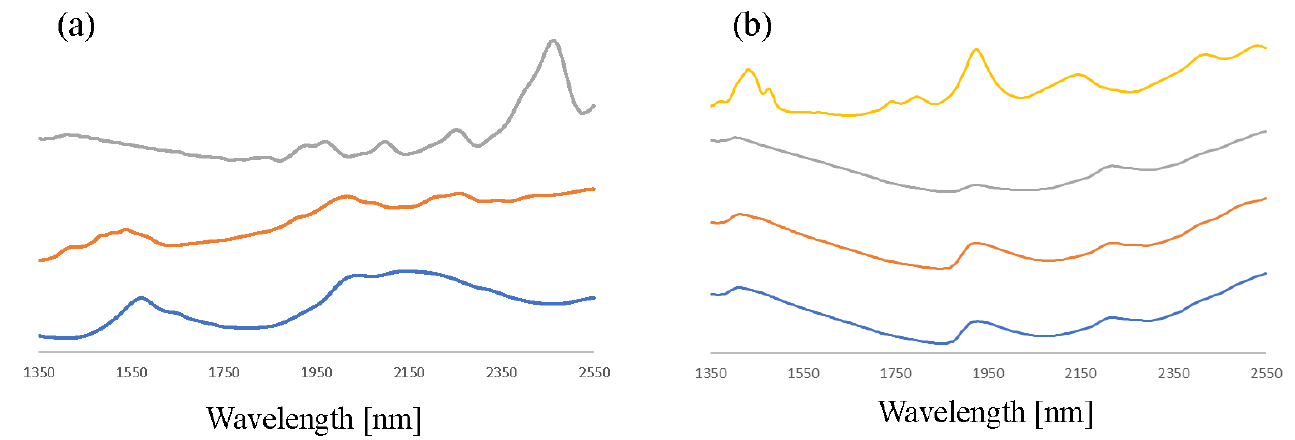
Figure 9. SNV-corrected, average NIR spectra (n = 5, n = 25 for KClO 3 and KClO 4 ) of ( a ) KNO 3 , urea nitrate, and ammonium nitrate (grey, orange, and blue trace, respectively) and ( b ) NaClO 4 (monohydrate), NaClO 3 , KClO 4 , and KClO 3 (yellow, grey, orange, and blue trace, respectively). The offset has been adjusted to facilitate spectrum comparison.